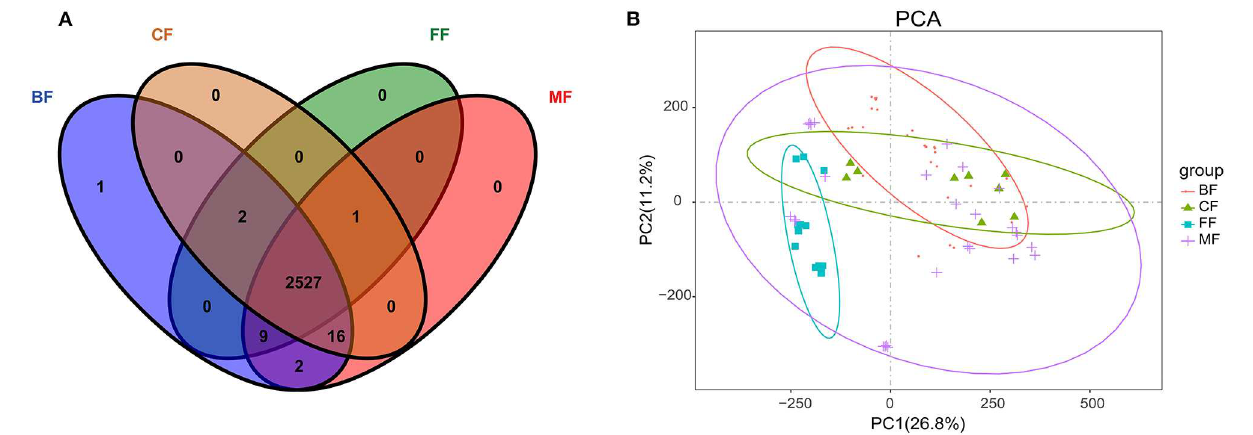
FIGURE 4 | (A) Venn diagram of metabolites among all groups. (B) Principal component analysis (PCA) diagram of metabolites in all fecal samples.